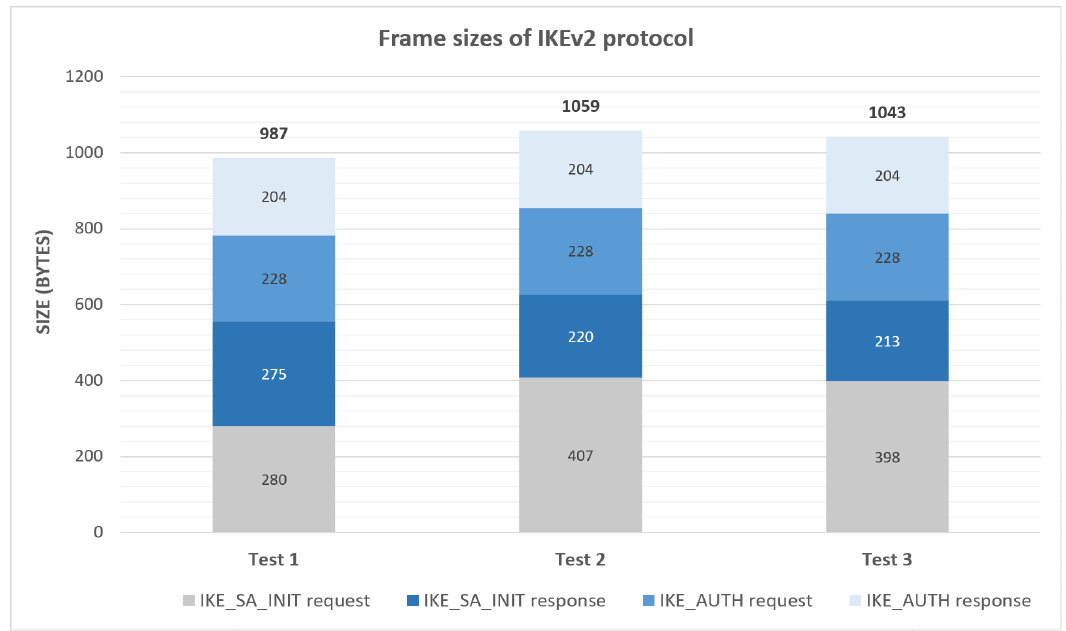
Figure 2. Frame sizes of IKEv2 protocol only taking into account IKEv2 header and